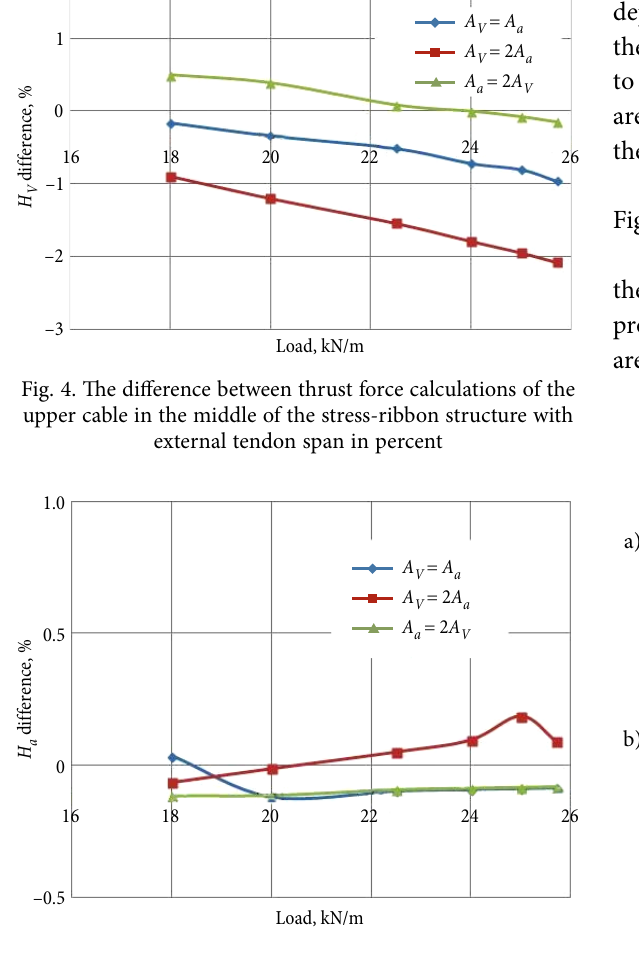
Fig. 6. Calculation diagram of the suspension structure: a) stress-ribbon using steel bands; b) stress-ribbon with external tendons